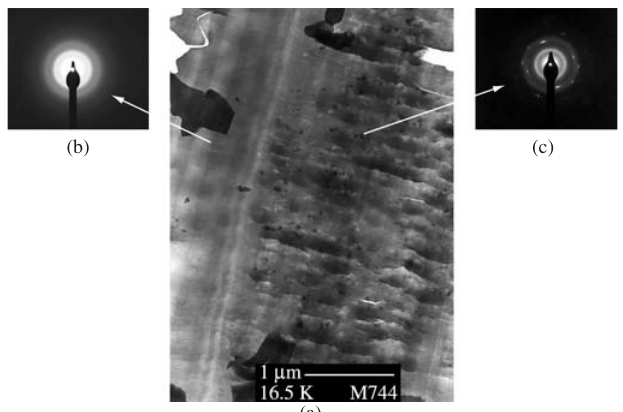
Figure 6. a) Bright-field TEM image of a part of a ductile chip; b) electron diffraction pattern which indicates that the structure of chip is amorphous; c) electron diffraction pattern which indicates that the structure of chip is amorphous and crystalline.